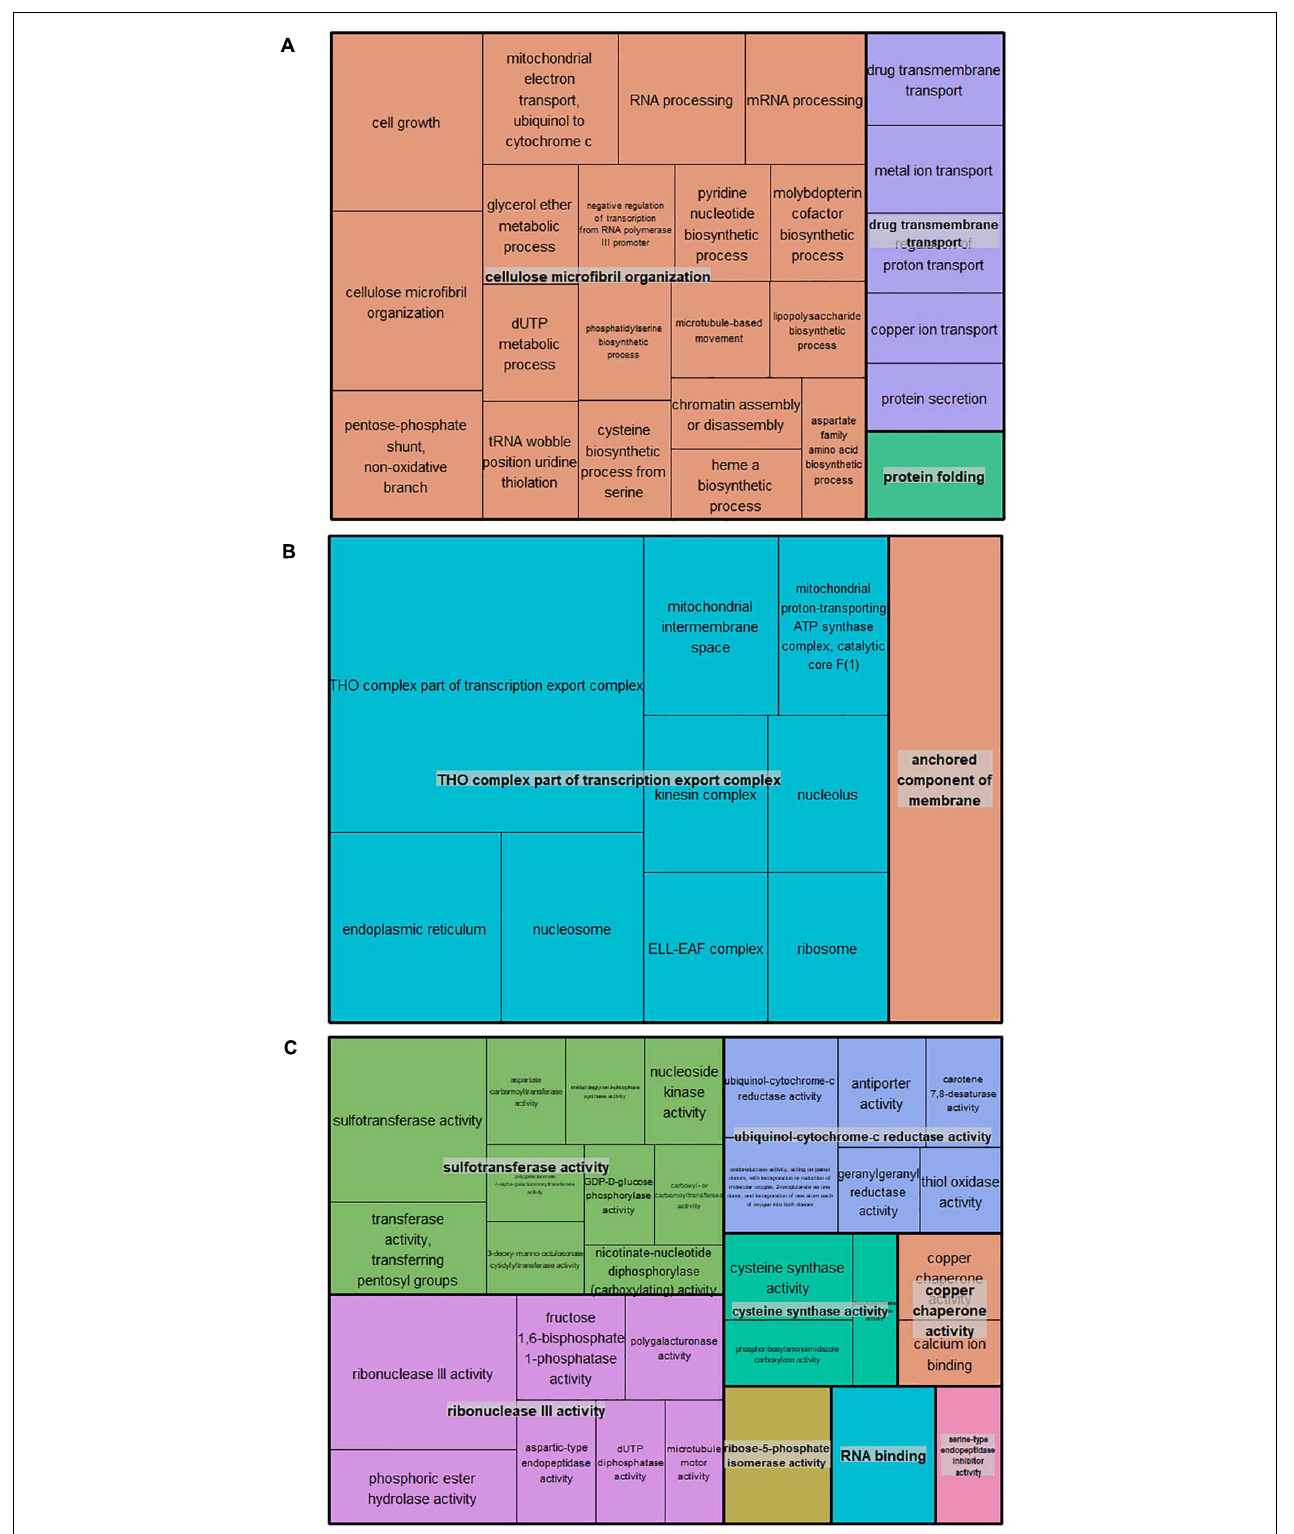
FIGURE 2 | TreeMap of the GO term cluster representatives joined into “superclusters” of biological processes (A) , cellular component (B) , and molecular functions (C) visualized with different colors. Each rectangle is a single cluster representative.